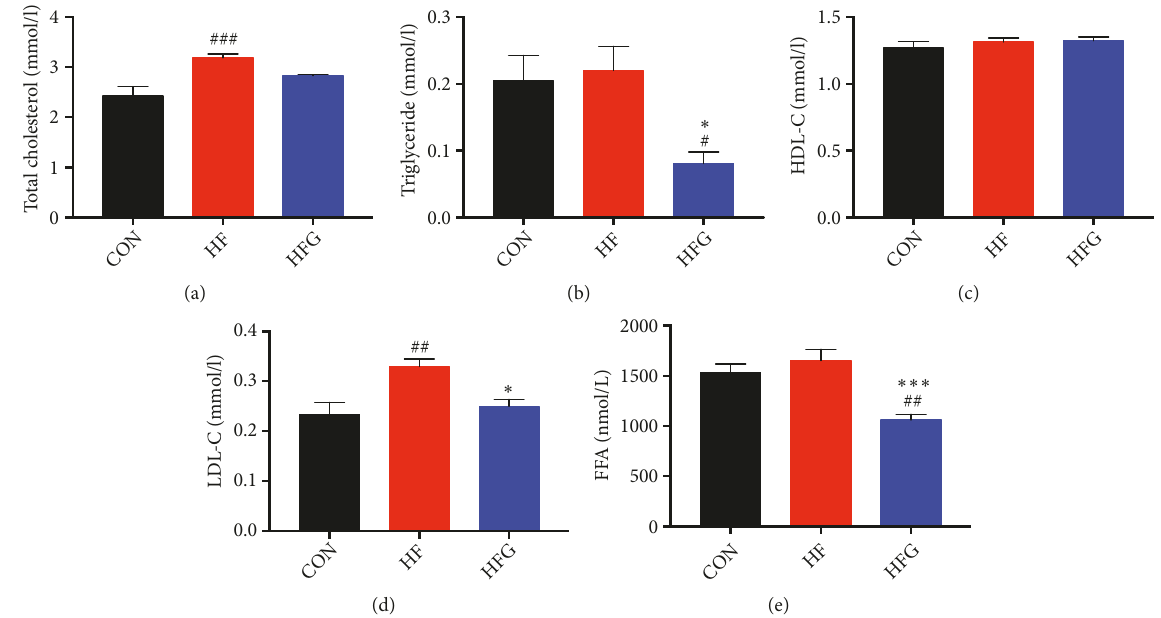
Figure 3: Dietary genistein could improve lipid metabolism. (a) Serum total cholesterol; (b) serum triacylglycerol; (c) serum HDL-C; (d) serum LDL-C, and (e) serum FFA. HDL-C: high-density lipoprotein cholesterol; LDL-C: low-density lipoprotein cholesterol; FFA: free fatty acids; CON: normal control diet; HF: high-fat diet without genistein; HFG: high-fatdiet with genistein. Data are expressed as means ± S.E.M. (n=8/group). Mean values were significantly different between other groups and the CON group: # p < 0.05; ## p < 0.01; ### p < 0.001. Mean values were significantly different between HF group and the HFG group: ∗ p < 0.05, ∗∗ p < 0.01, ∗∗∗ p < 0.001.